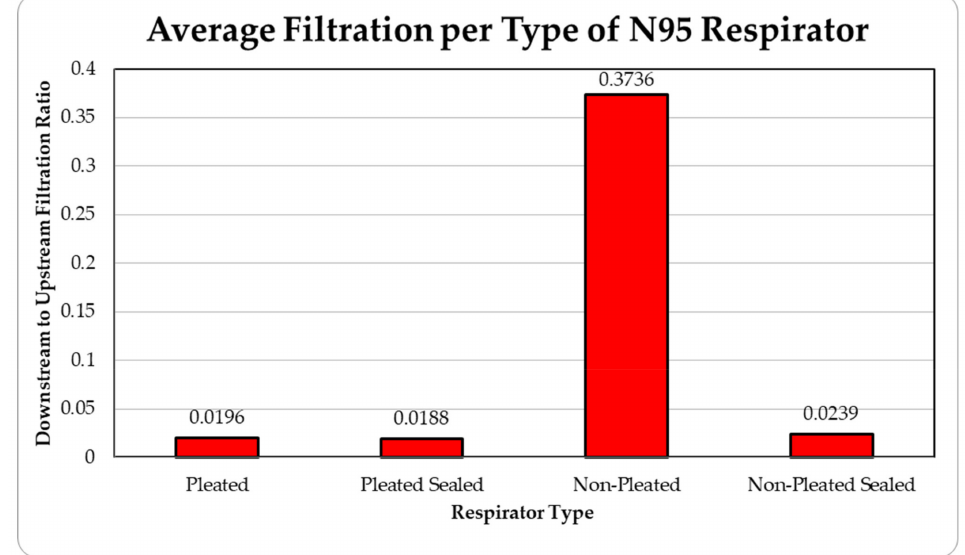
Figure 9. Average filtration ratios of total particles per type of respirator at the Observer Position Stick Welding.